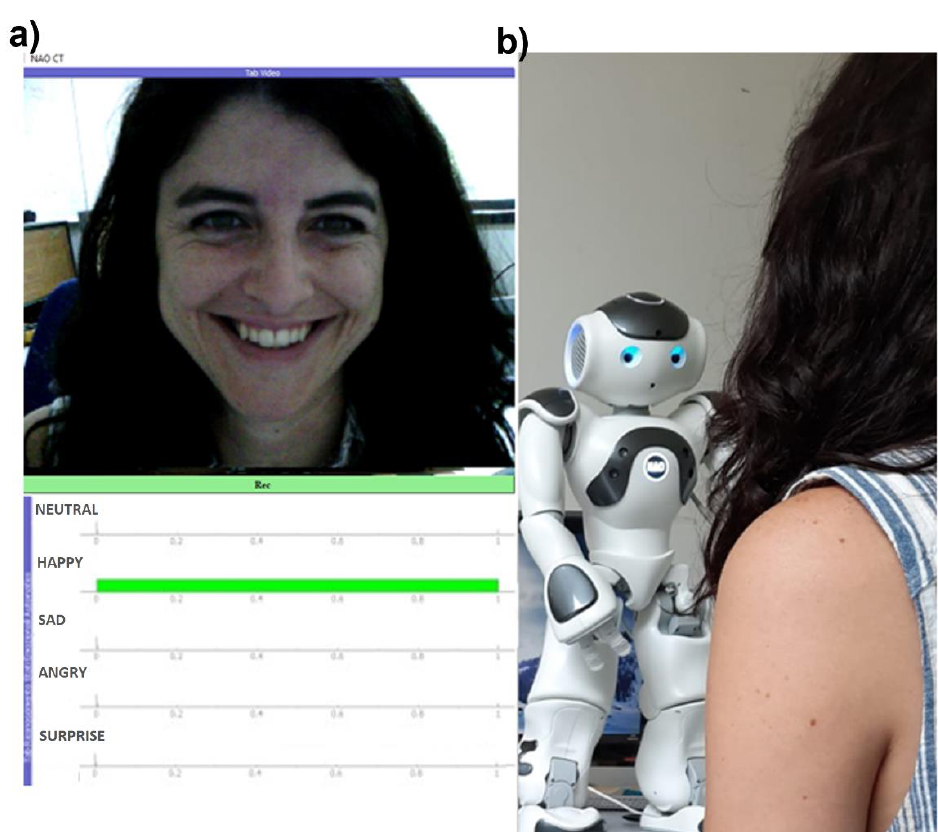
Figure 3. ( a ) Representation of the developed GUI reporting the image acquired from the NAO’s forehead webcam and NAO’s FER module outcome in real-time. ( b ) Interaction between NAO robot and a representative participant.